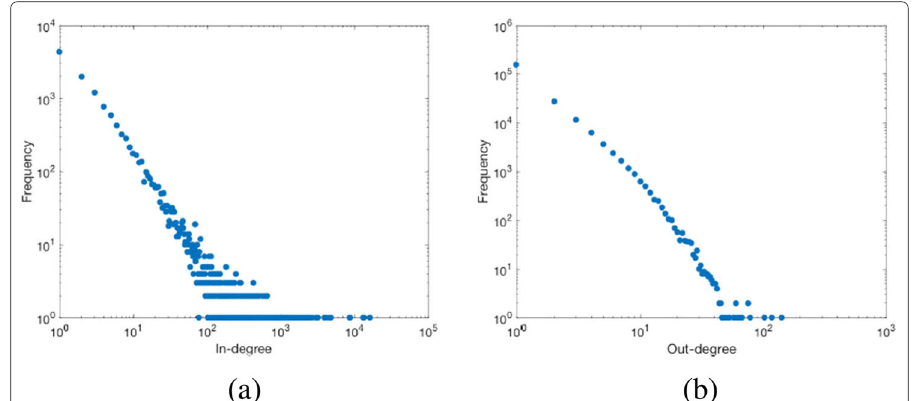
Fig. 1 Degree distributions for the retweet network G . In-degree represents the number of times that a node was retweeted, and out-degree represents the number of times that a node posted a retweet. The two distributions differ from each other, with the in-degree distribution having a longer tail (corresponding to a few accounts that were retweeted very heavily). ( a ) In-degree distribution and ( b ) out-degree